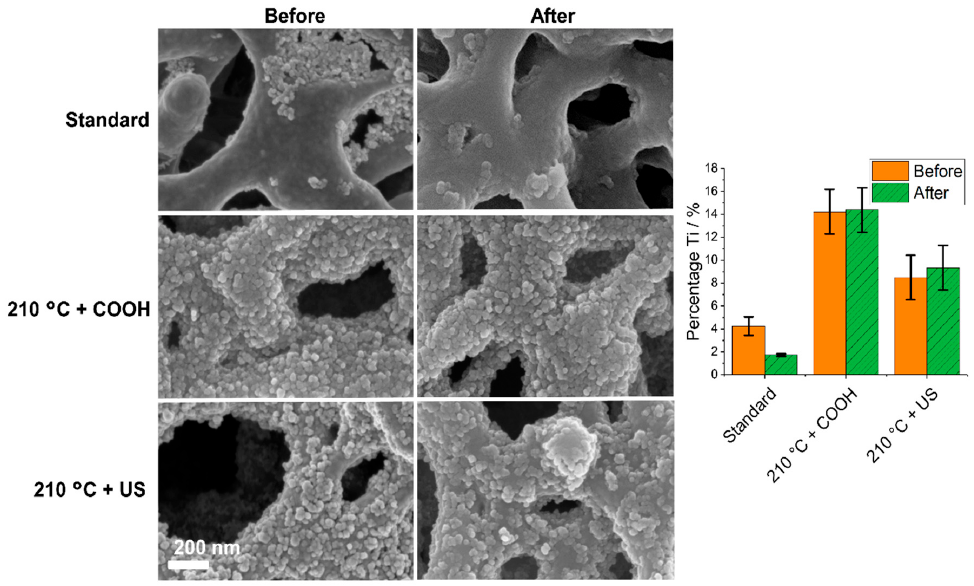
Figure 6. SEM images of the membrane surface ( left ) and percentage of titanium ( right ) on the membrane before and after stability test for the membrane modified with TiO 2 nanoparticles via the standard 210 °C, 210 °C + COOH, and 210 °C + US